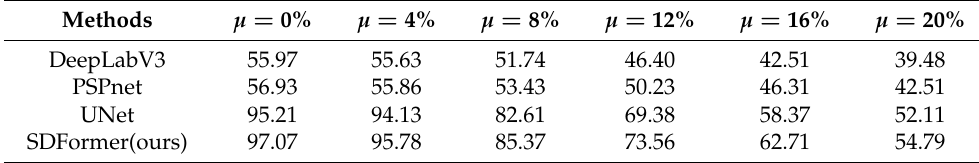
Table 3. MIoU of anti-noise test on plate